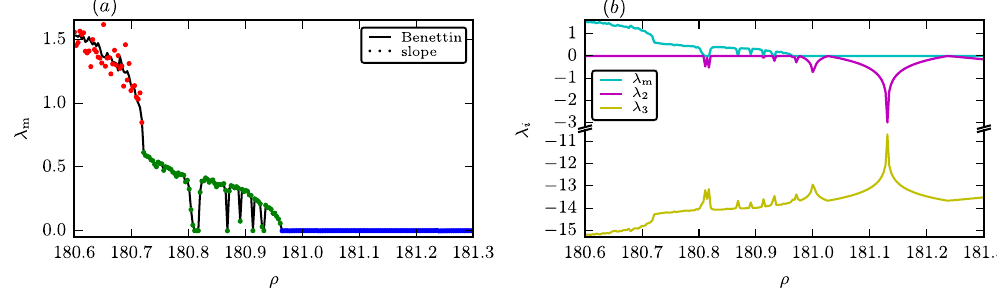
Figure 6. The Lyapunov exponents of the Lorenz system for ρ ∈ [180.6, 181.3]. ( a ) Comparing the maximal average Lyapunov exponent λ m obtained using the method of Benettin 21 (solid line) and from the initial slope of the averaged logarithmic distance 〈 ln| x 1 ( t ) − x 2 ( t )| 〉 (dots). The distinct regimes are color coded (red/green/blue for strong chaos/PPC/laminar flow). ( b ) All three average Lyapunov exponents λ i computed by the method of Benettin 21, 22 . (Note the break in the vertical